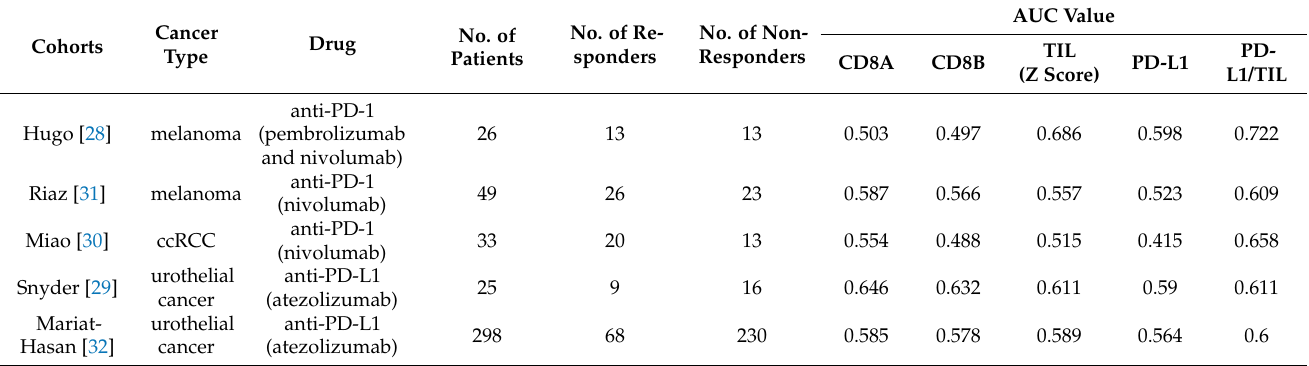
Table 1. The sample size statistics and AUC value of different indicators for the immunotherapy research cohort.